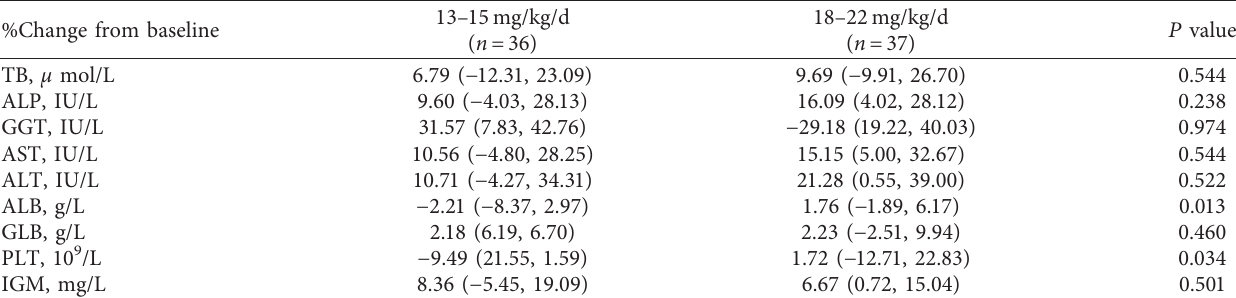
Table 6: Percentage of biochemical relative changes from baseline at 6months.